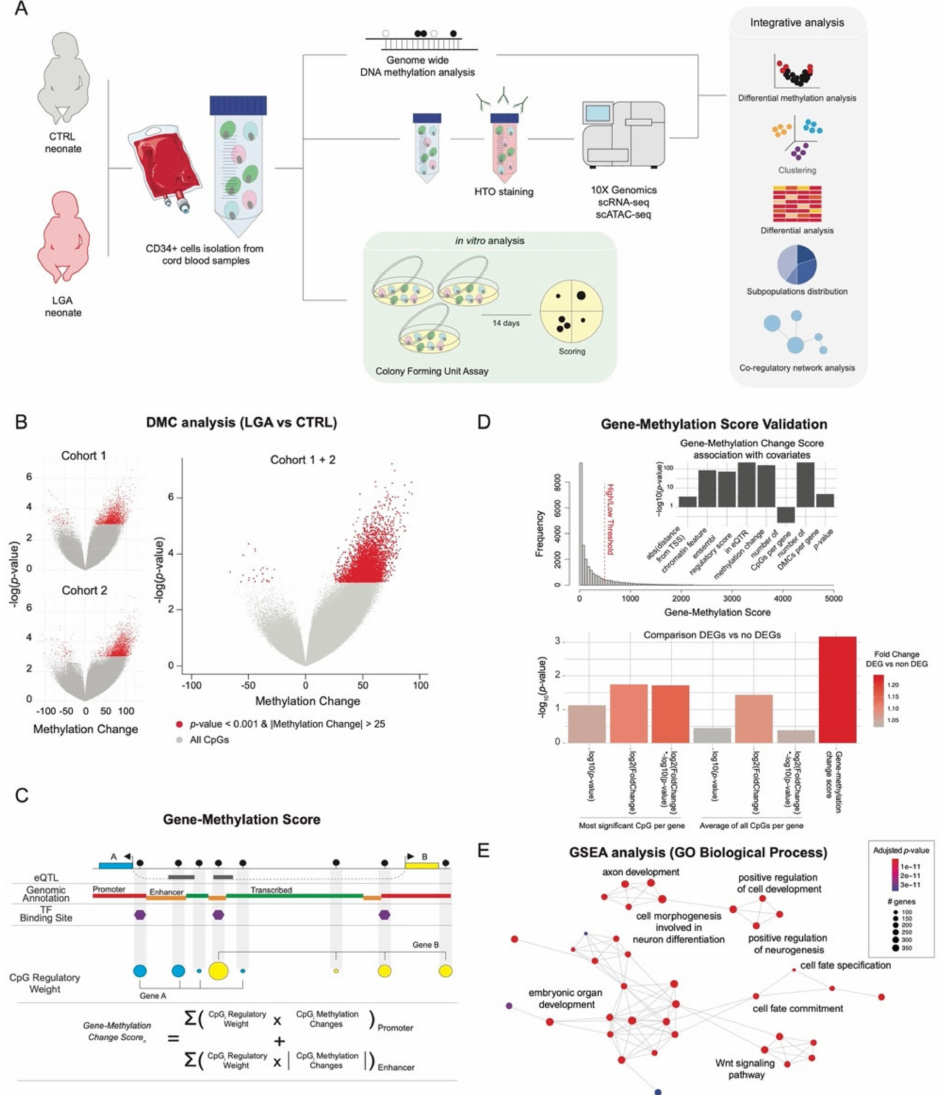
Figure 1. LGA is associated with DNA hypermethylation targeting key stem cell signaling path- ways. ( A ) Overview of study design ( B ) Volcano plot of DNA methylation score differences for LGA compared to CTRL in cohort 1, cohort 2, and cohort 1 + 2. Differentially methylated loci with p -value < 0.001 and |methylation difference| > 25% are shown in red. ( C ) Summary of calculation for the gene-methylation score. ( D ) Validation of the gene-methylation score. Gene-methylation score distribution. Bar plot of the association between gene-methylation score and genomic or methylation- related features. Bar plots representing the significance of the difference in gene-methylation score of DEGs compared to non-DEGs considering different metrics. eQTR, region with expression quantita- tive traits loci; DMC, differentially methylated CpGs. ( E ) Network representation of GO Biological Process enriched in hypermethylated genes. Significantly enriched GO terms were identified using GSEA based on the gene-methylation score. Edges represent interactions (gene overlap) between